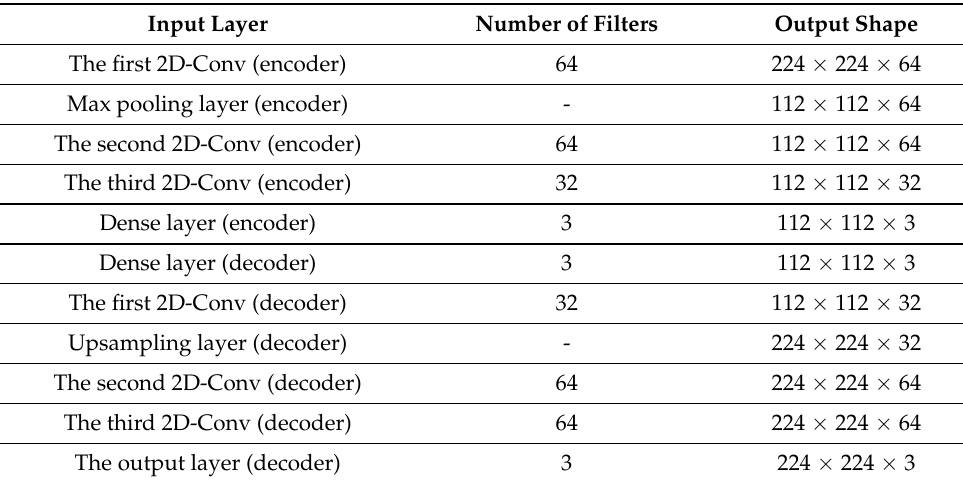
Table 2. Autoencoder